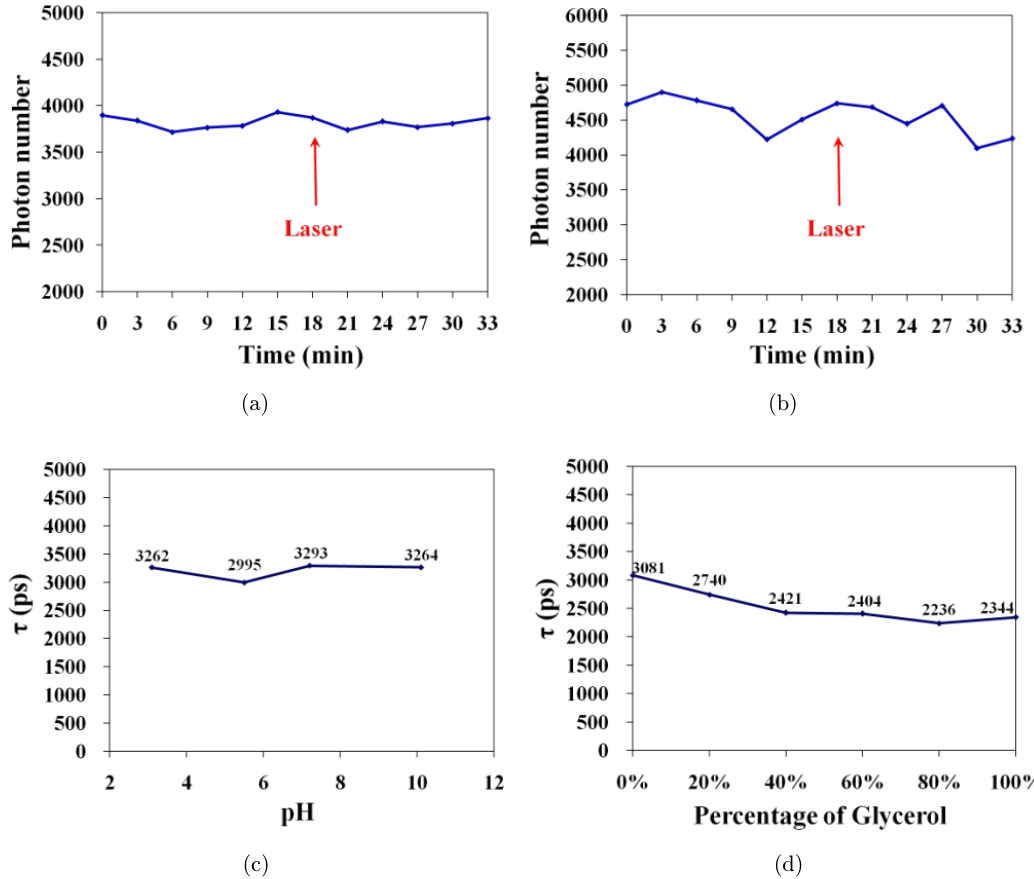
Fig. 5. (a) – (b) The trends of photon numbers collected in 1min from samples of the R123 solution in vitro (a) or of the R123 in cells (b) under NIR laser irradiation (808 nm, 1 W/cm 2 ). (c) – (d) The °uorescence lifetimes of R123 dye in PBS solutions